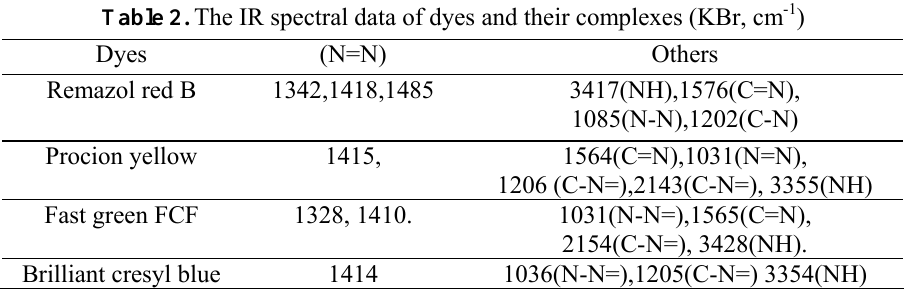
Table 3. Absorption spectral data of dyes and their